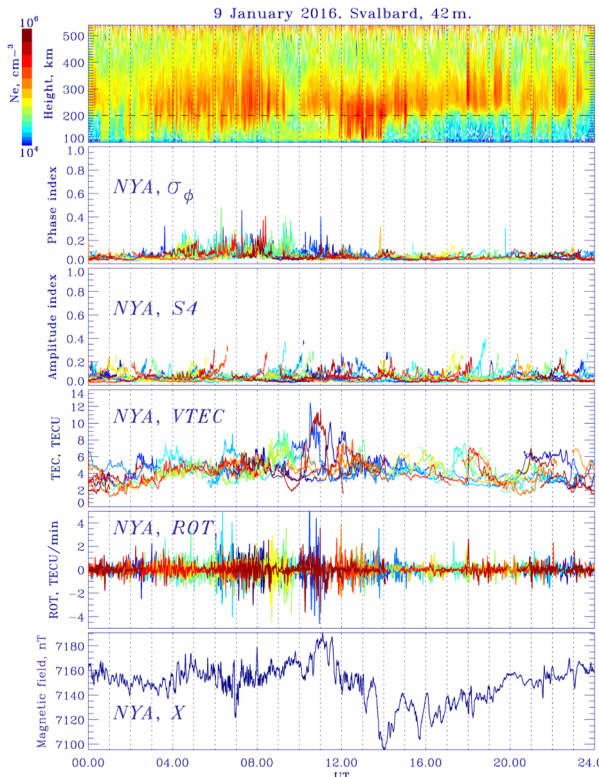
Figure 1. Ionosphere plasma density according to the EISCAT 42m radar data, phase scintillation index and amplitude scintillation in- dex according to the GPS receiver at NYA station, TEC and ROT variations according to the GPS receiver at NYA station, and geo- magnetic field variations ( X component) at NYA station for 9 Jan- uary